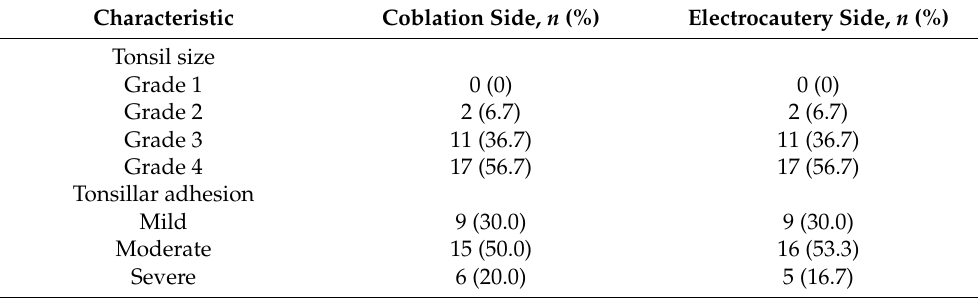
Table 2. Size and adhesion level of